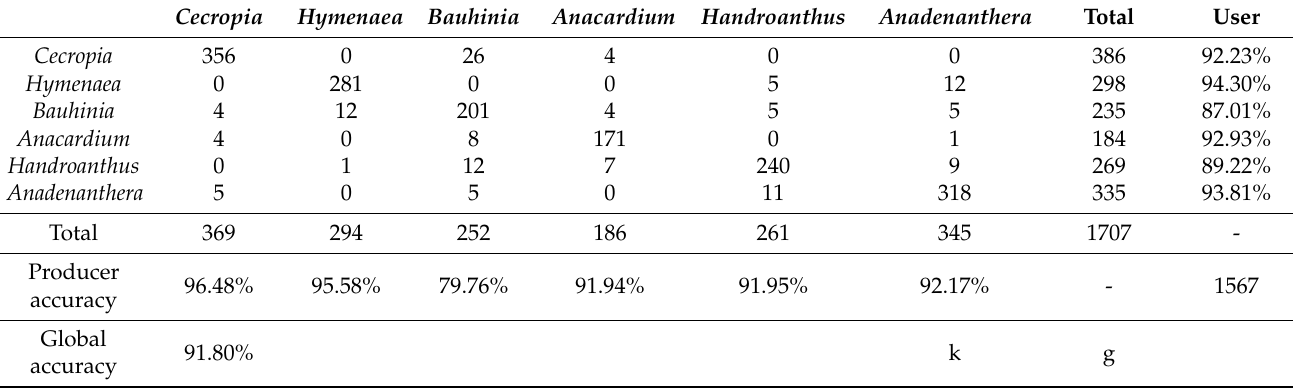
Table 4. Confusion matrix with the insertion of six species in a convolutional neural network with threshold =